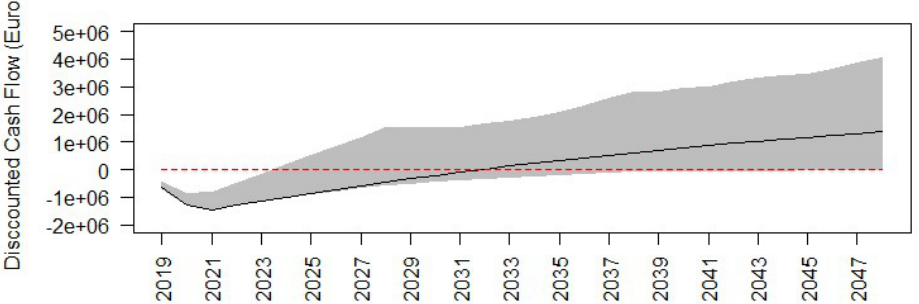
Figure 2. Discounted cumulative cash flow in Thinking Fadura. Black curve shows the selected scenario (discount rate = 3.5%, time horizon = 30 years, Assumed values for items with high uncertainty = 0%, and Changes in future use = 0%). Grey area indicates the range of variability. Upper limit and lower limit of the grey area indicate percentile 5 and percentile 95 of the 54 evaluated scenarios in the sensitivity analysis. Red and dashed line indicates 0 euros.